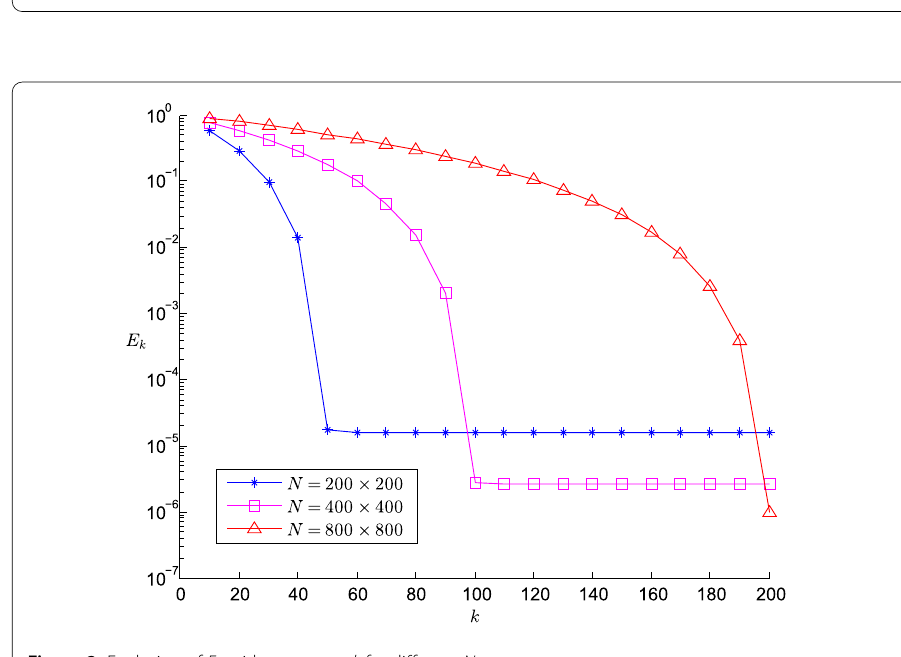
Figure 2 Evolution of E k with respect to k for different